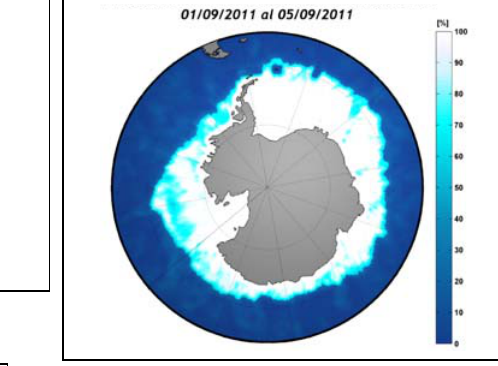
Figure 5: Sea Ice Concentration in Antartica from MWR.